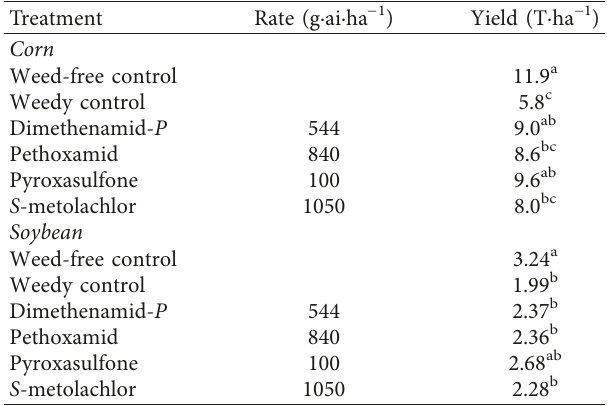
Table 1: Yield of corn and soybean treated with various VLCFA inhibitor herbicides, applied preemergence (PRE), near Exeter and Ridgetown in 2015–2017 a